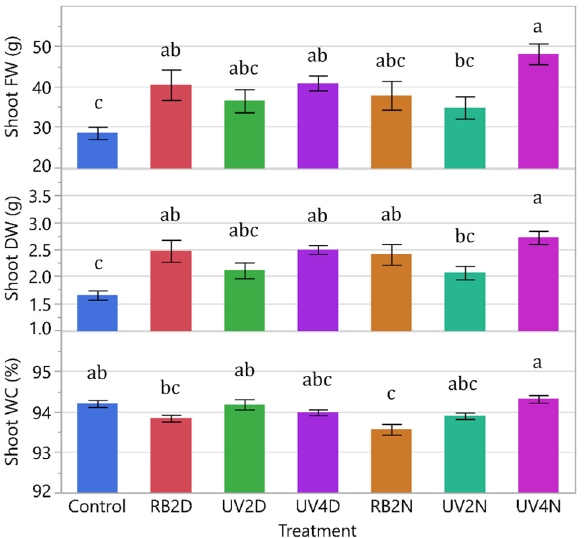
Figure 2. Shoot fresh weight (FW), dry weight (DW), and shoot water content (WC) of the lettuce variety ‘Red Mist’ treated with a pre-harvest supplemental UV-A/Blue (UV) or Red and Blue (RB) LED light for a duration of either two or four days (D) or nights (N) in a greenhouse hydroponic system (Experiment 1). The control plants did not receive any supplemental LED light. See Table 2 for treatment details. Means separated by different letters indicate significant differences according to Tukey’s HSD (honestly significant difference) test ( p < 0.05). Bars represent standard error.